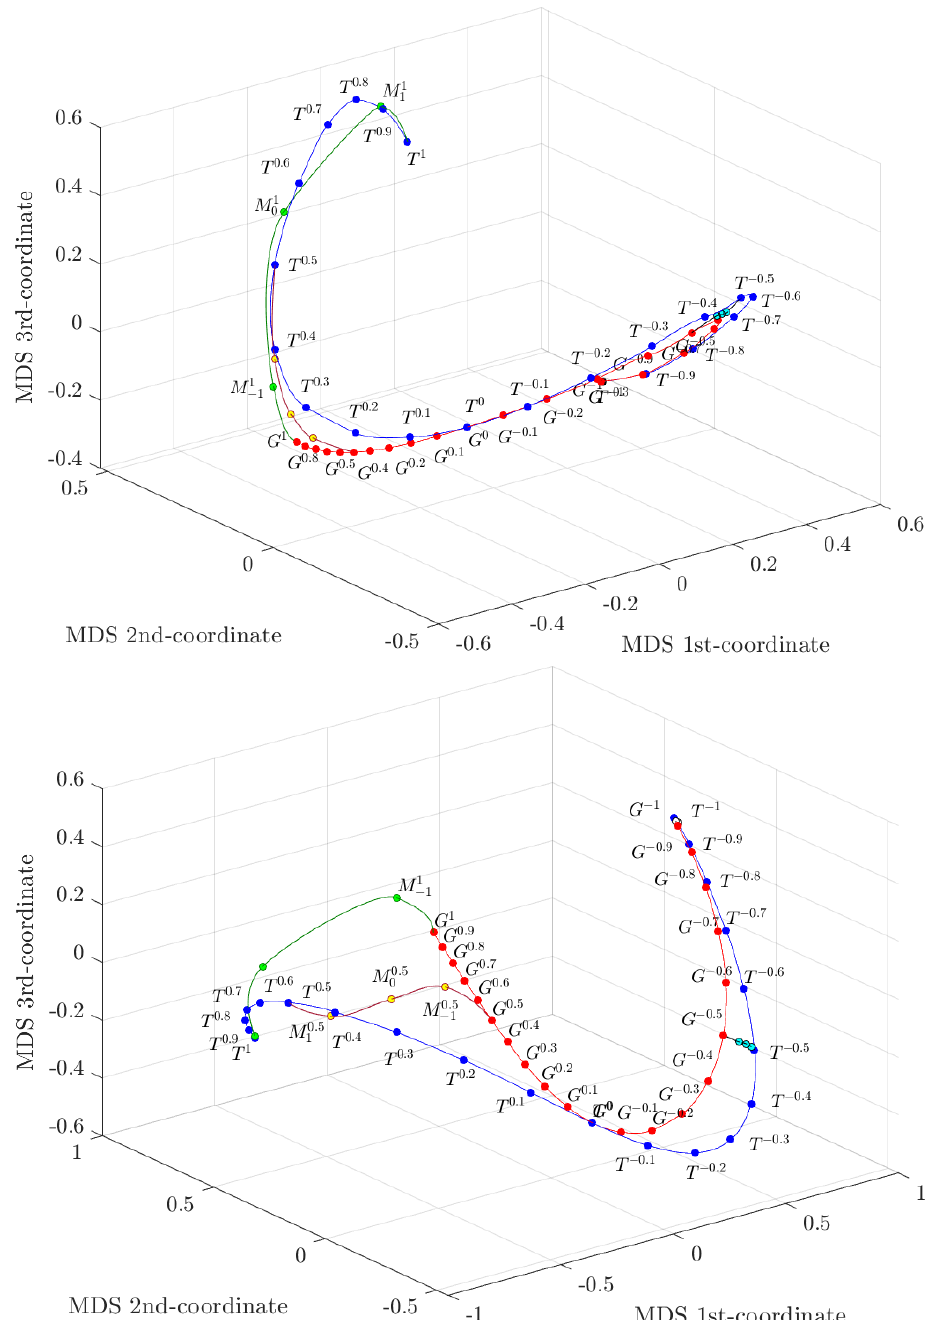
Figure 7. MDS loci of the N = 54 numerical series produced by the Jaccard ( top ) and ArcCosine ( bottom ) distances, d Ac , for r =